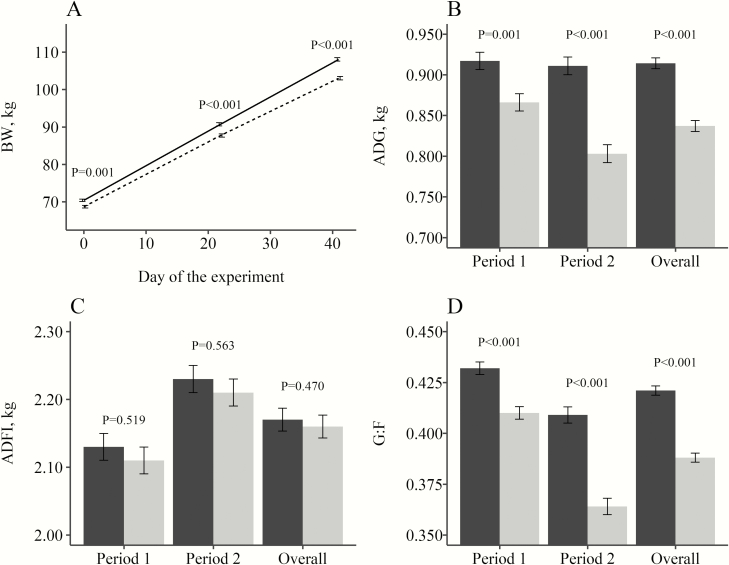
Effect of sex on body weight (A), average daily gain (B), average daily feed intake (C), and gain to feed (D) of finishing boars and gilts. For A, data represent the three weighing days. For B, C and D results are provided for Period 1 (70 to 89 kg), Period 2 (89 to 106 kg) ,and the overall experiment (70 to 106 kg). Solid line and black bars represent boars, whereas dashed line and gray bars represent gilts. Error bars represent the SEM.